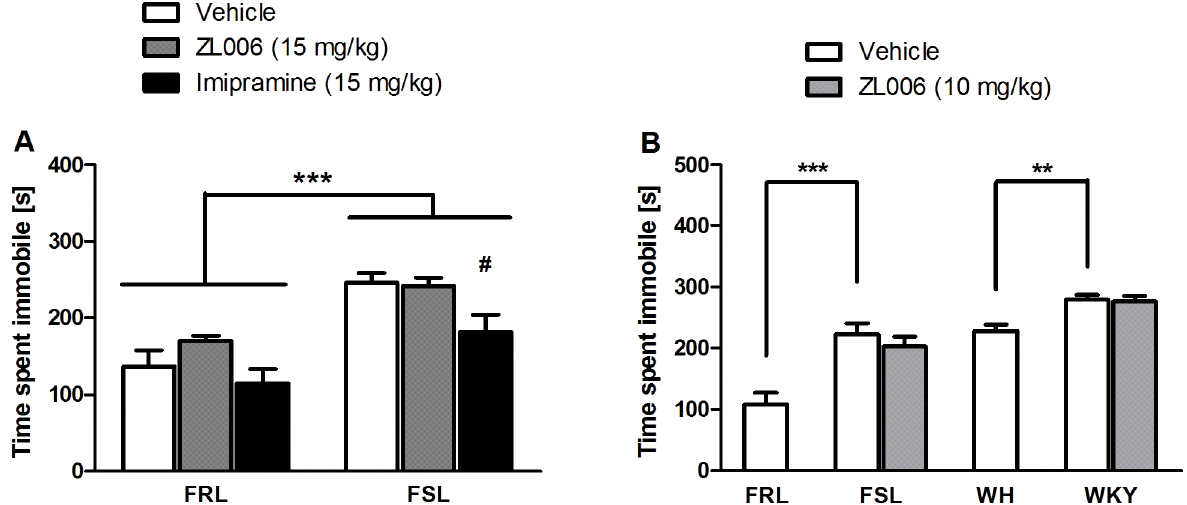
Fig 4. Systemiceffectsof repeated injections of ZL006 in Flinders Sensitive/Resistant Line and Wistar Kyoto/Wistar Hanover rats. A : Effects of ZL006 in FSL/FRL rats in a 5-min Forced Swim Test session after repeatedinjections (24 h, 19 h, 1 h prior to the FST) of vehicle, ZL006 (15 mg/kg), or imipramine (15 mg/kg). A significantstrain difference indicatedthat FSL rats were more immobilethan FRL rats; *** : p (cid:20) .001. Moreover, imipramine-treated FSL rats were significantly less immobilethan vehicle-treated FSL rats; #: p (cid:20) .05; n = 6–10/group. B : Effects of ZL006 in FSL, FRL, Wistar Kyoto (WKY), and Wistar Hanover rats (WH) after repeated injections(24 h, 19 h, 1 h prior to the FST) of vehicle or ZL006 (10 mg/kg). When comparing vehicle-treatedrats, FSL rats were more immobilethan FRL rats, and Wistar Kyoto rats were more immobilethan Wistar Hanoverrats; ** : p (cid:20) .005; *** : p (cid:20) .001; n = 8/group. Values are expressedas means ± SEM and were analyzedusing a two-way ANOVA (A) and two separate one-wayANOVAs (B) followedby pairwise